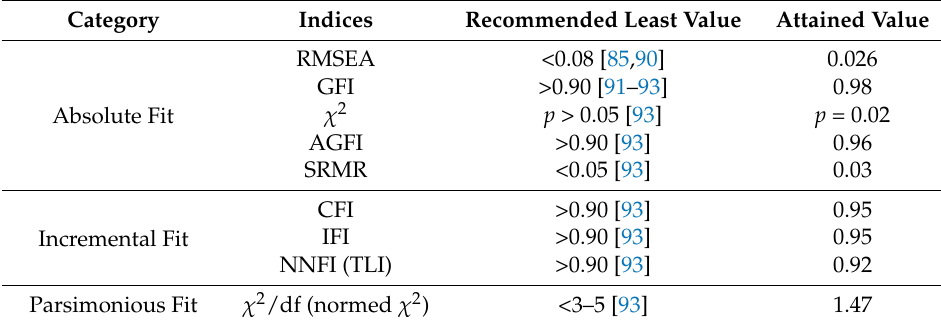
Table 5. Goodness of fit